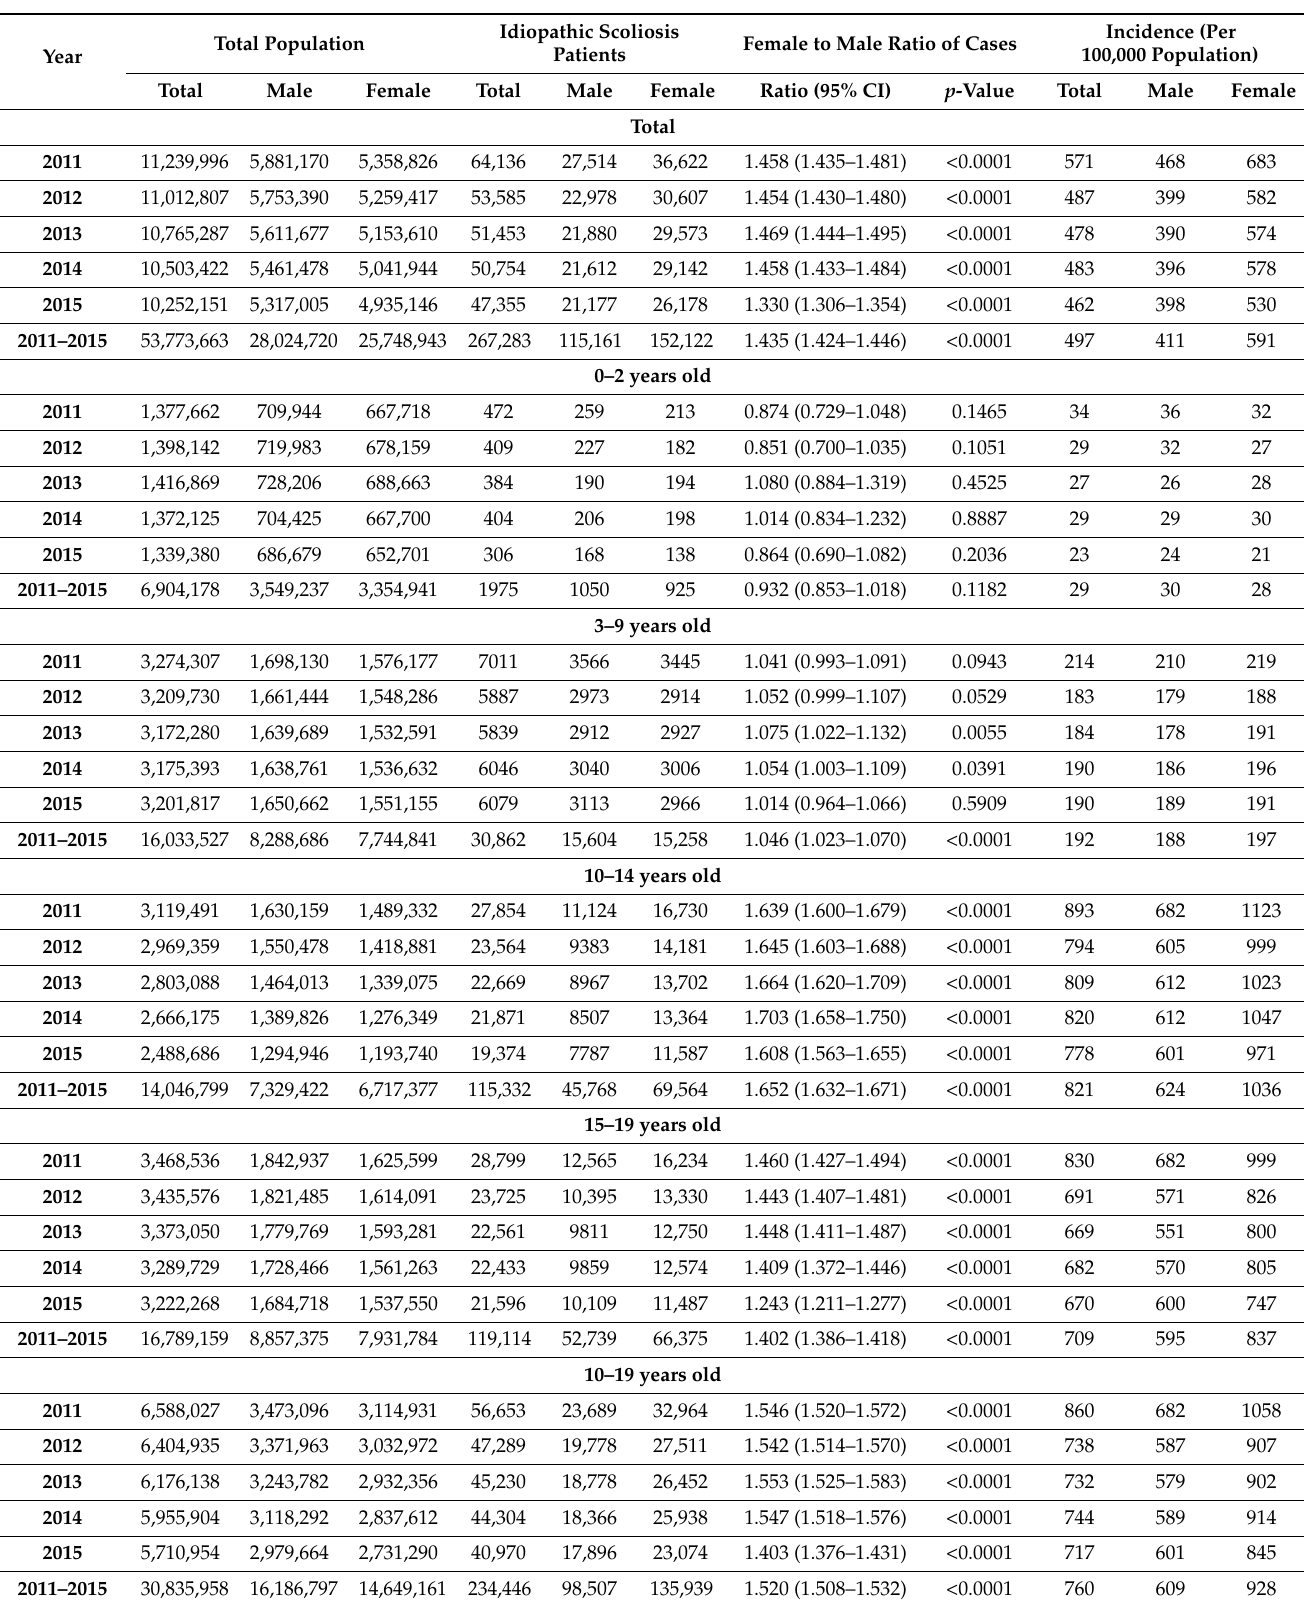
Table 2. Annual incidences of idiopathic scoliosis by age